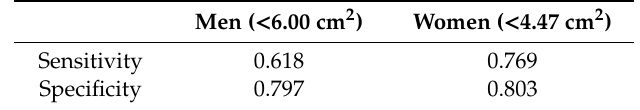
Table 5. Sensitivity and specificity of the RF CSA in discriminating PEW risk.